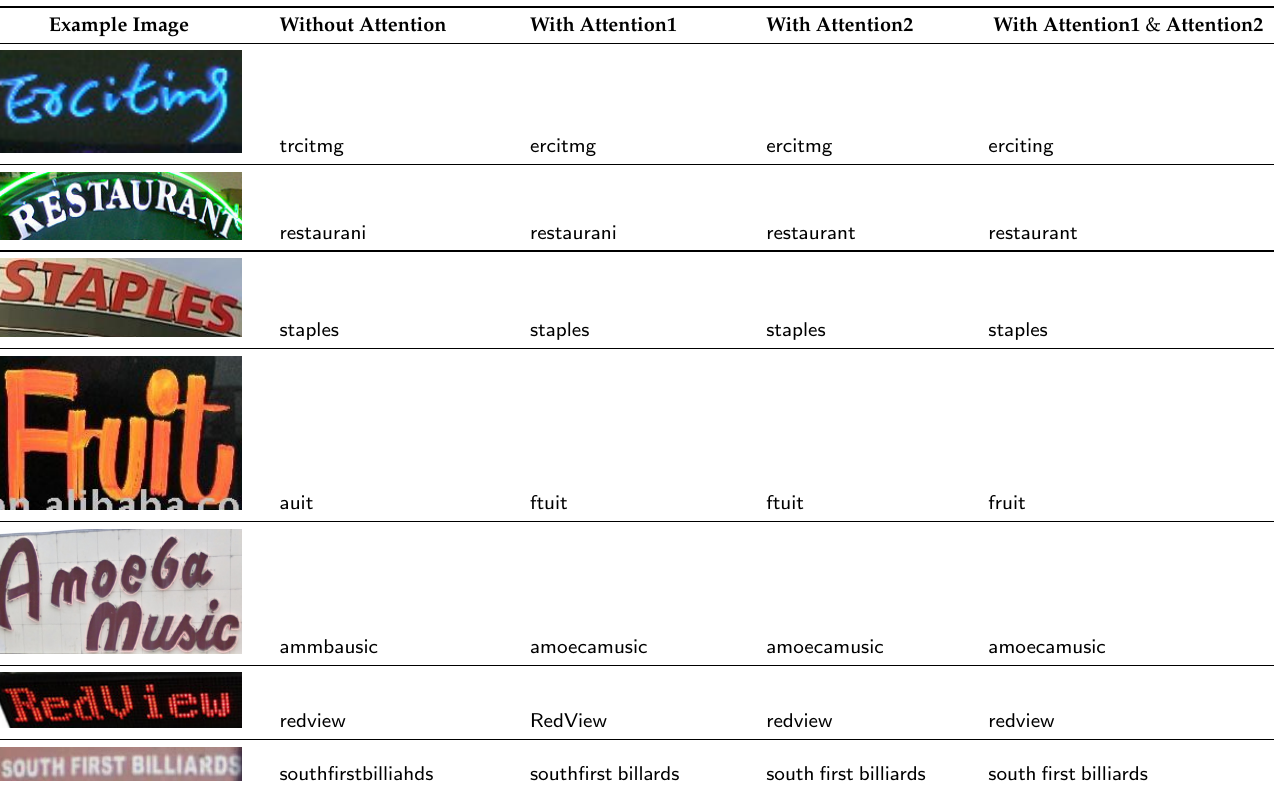
Table 4. Example images and recognized text labels by the proposed network under different attention block